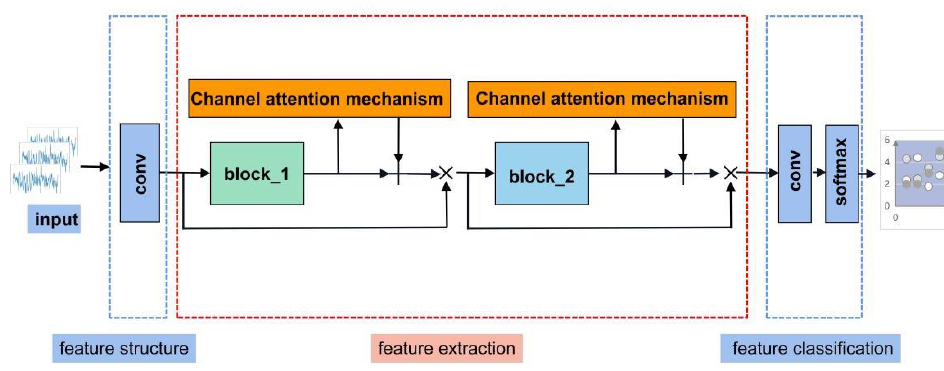
Figure 2. The architecture of the camResNet model.